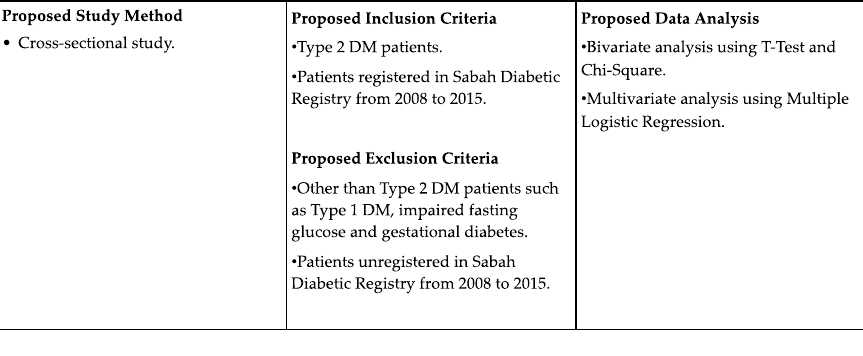
Figure 2. Suggested study t o determine the prevalence of diabetic retinopathy (DR) and identify risk factors associated with DR among type 2 diabetes mellitus (DM) patients across primary health clinics in Sabah, Malaysia.